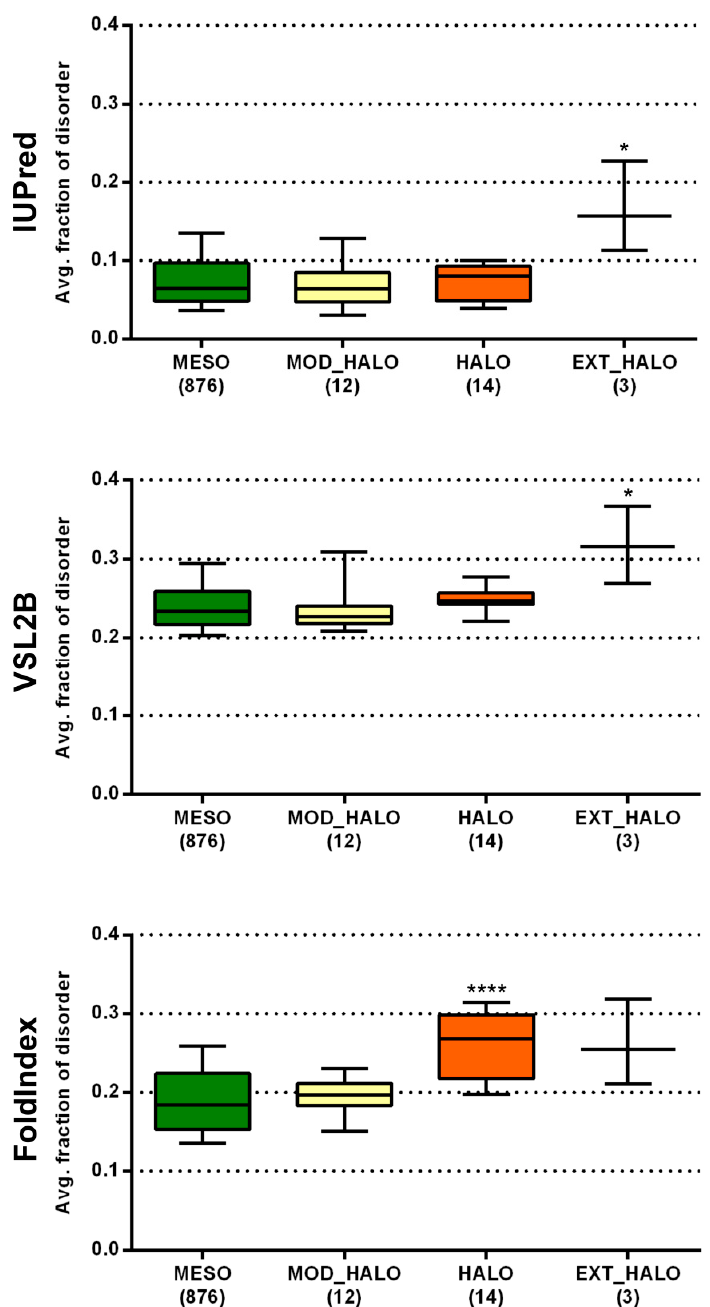
Figure 4. Predicted disorder content of different extremity classes of bacterial halophiles. The average fraction of disordered residues was calculated for each proteome by three prediction methods. The distribution of the calculated values of each class was compared to that of mesophiles by Dunn’s multiple comparison test, with the significance levels indicated as stars above the boxes (* p < 0.05; **** p < 0.0001). MESO—mesophiles, MOD_HALO—moderate halophiles, HALO—halophiles, EXT_HALO—extreme